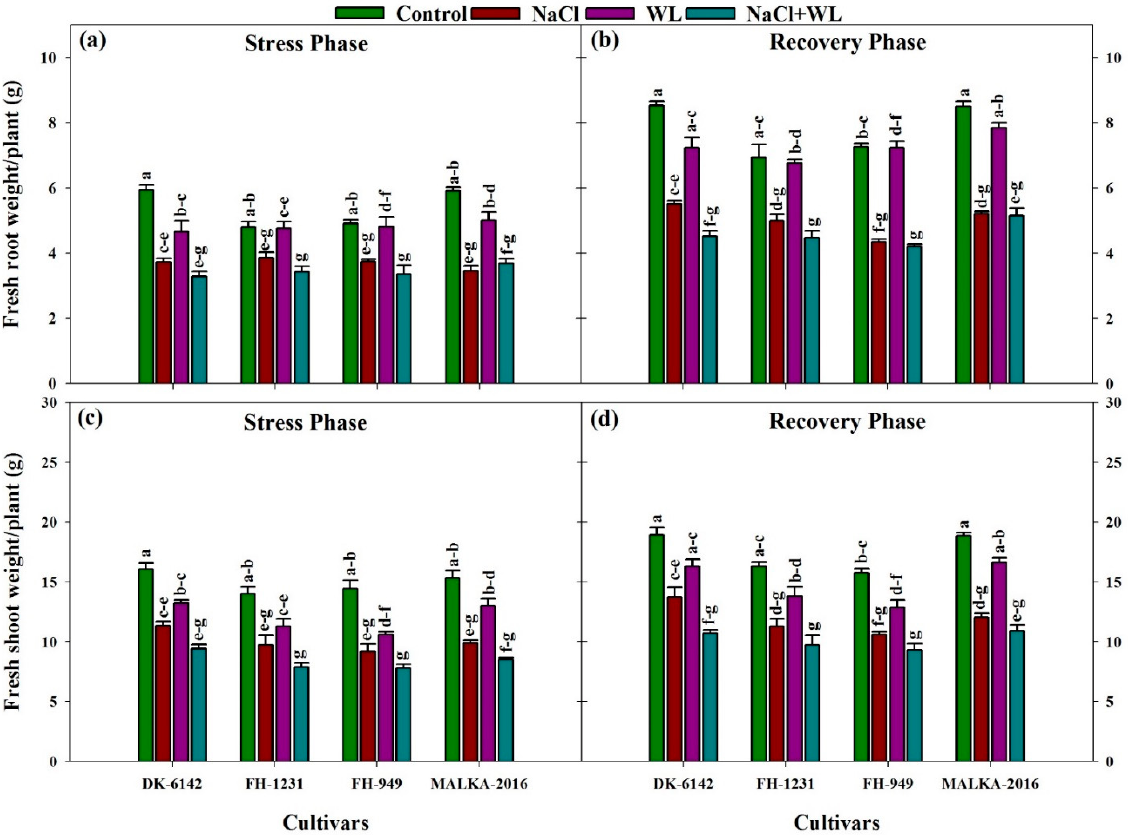
Figure 2. Individual and interactive effects of salinity and waterlogging on root and shoot fresh weight (g) of four maize cultivars during the stress (22 DAS) and recovery (30 DAS) phases. Left and right sides of the figure are representing stress phase and recovery phase respectively. Error bars denote the standard error of three replications. Bars with same letter do not differ significantly at p ≤ 0.05.